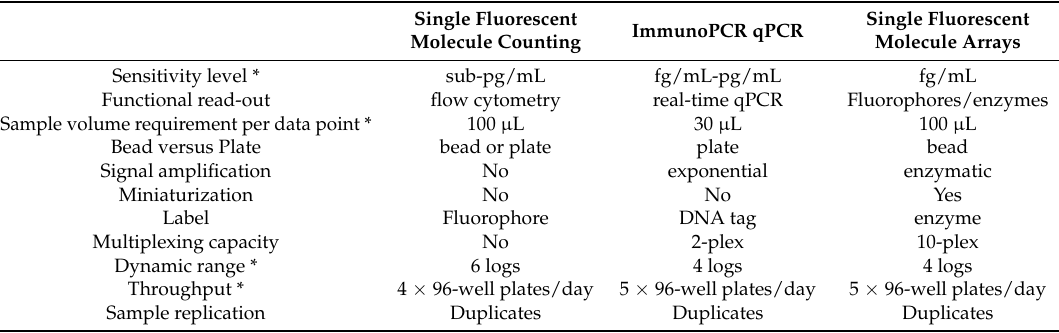
Table 3. Sensitivity improvements made by modifying immunoassay steps. * The numbers shown in the row can be considered as a general point of reference as they represent the best values found in various commercial products using the specified